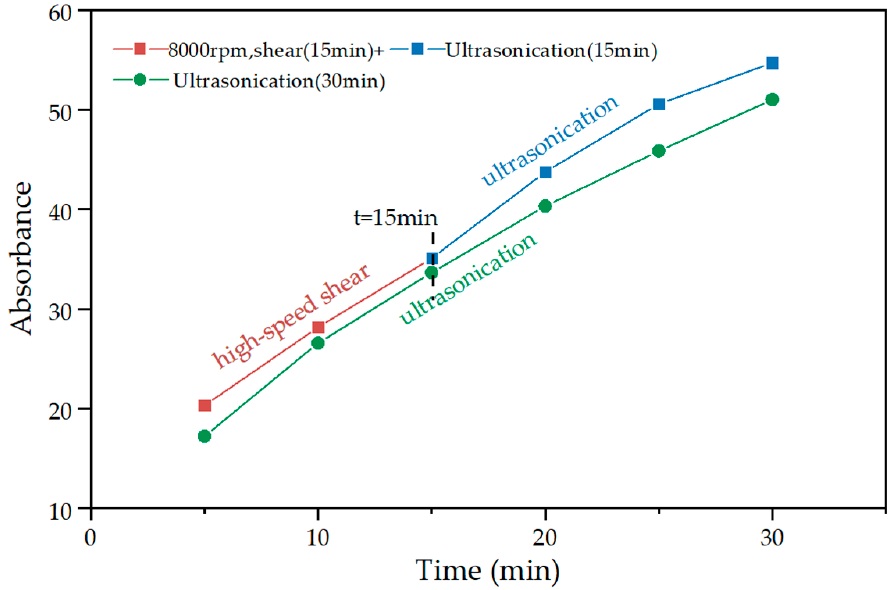
Figure 8. A comparison of high-speed shear (partial replacement ultrasonication) and only ultrasonication. Figure 9 shows the optimal dispersion method to prepare GNPs suspensions.